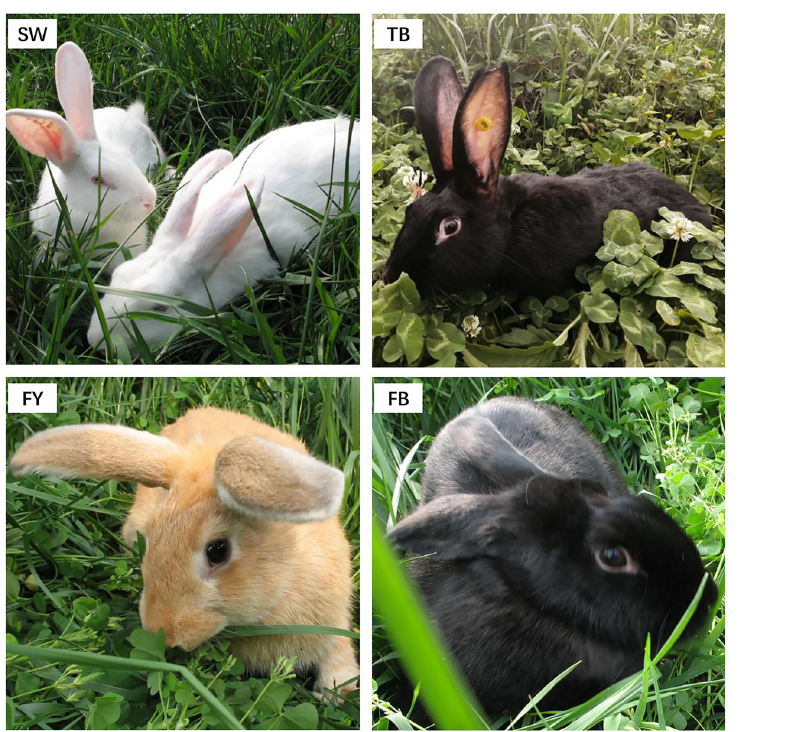
Fig 1. Rabbit pictures from each of the four indigenous breeds in this